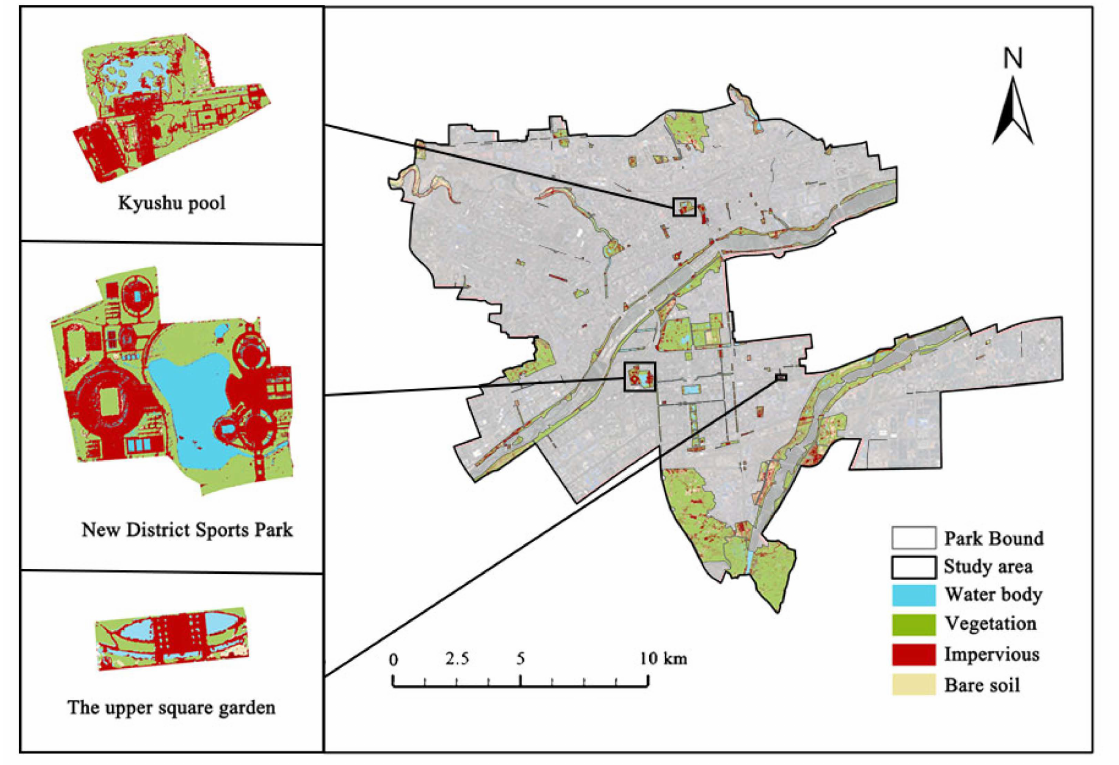
Figure 3. The land cover classification of